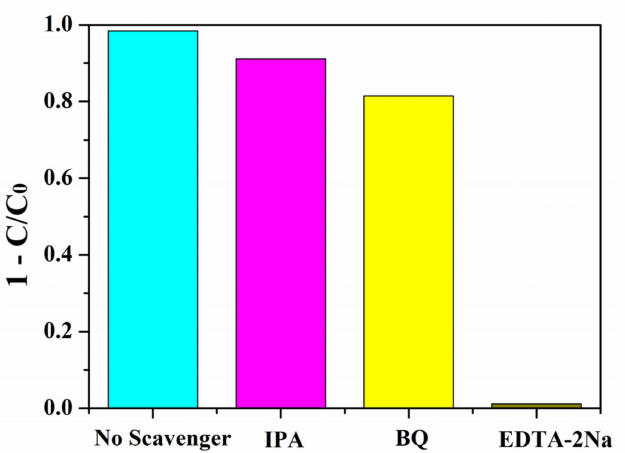
Figure 11. Trapping experiment of active species on the degradation of RhB in the presence of BNMT-9 under visible-light